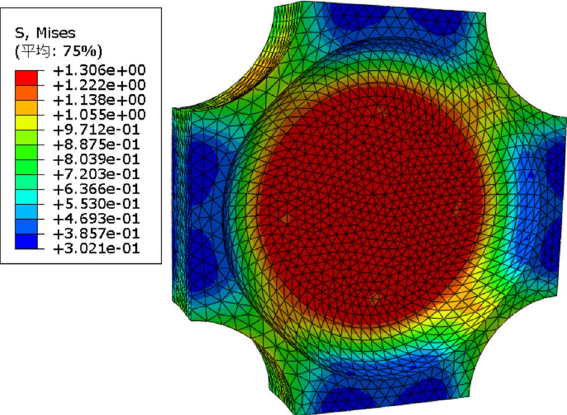
Figure 2. Mises stress of test piece